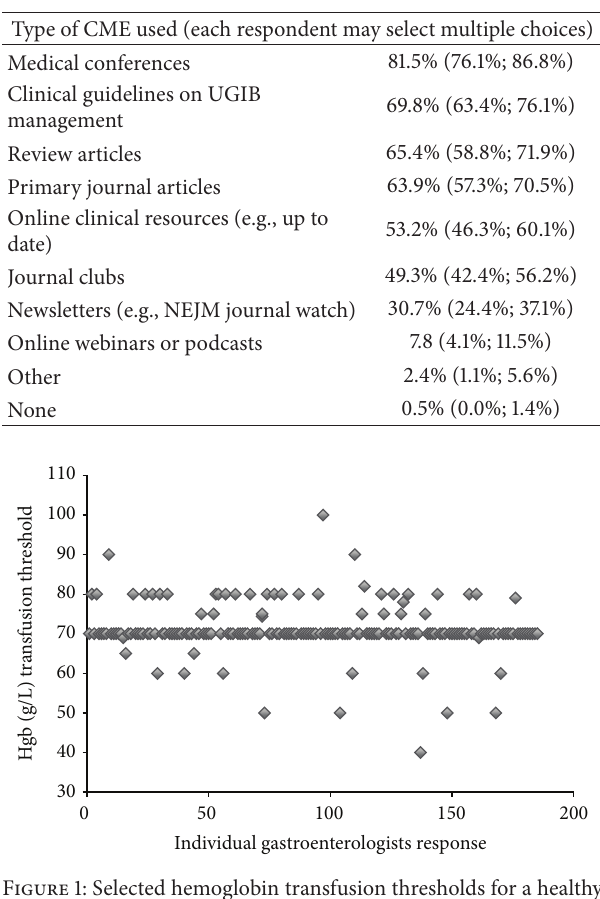
Table 2: Continuing medical education (CME) used for manage- ment of UGIB ( 𝑛 = 203 ).